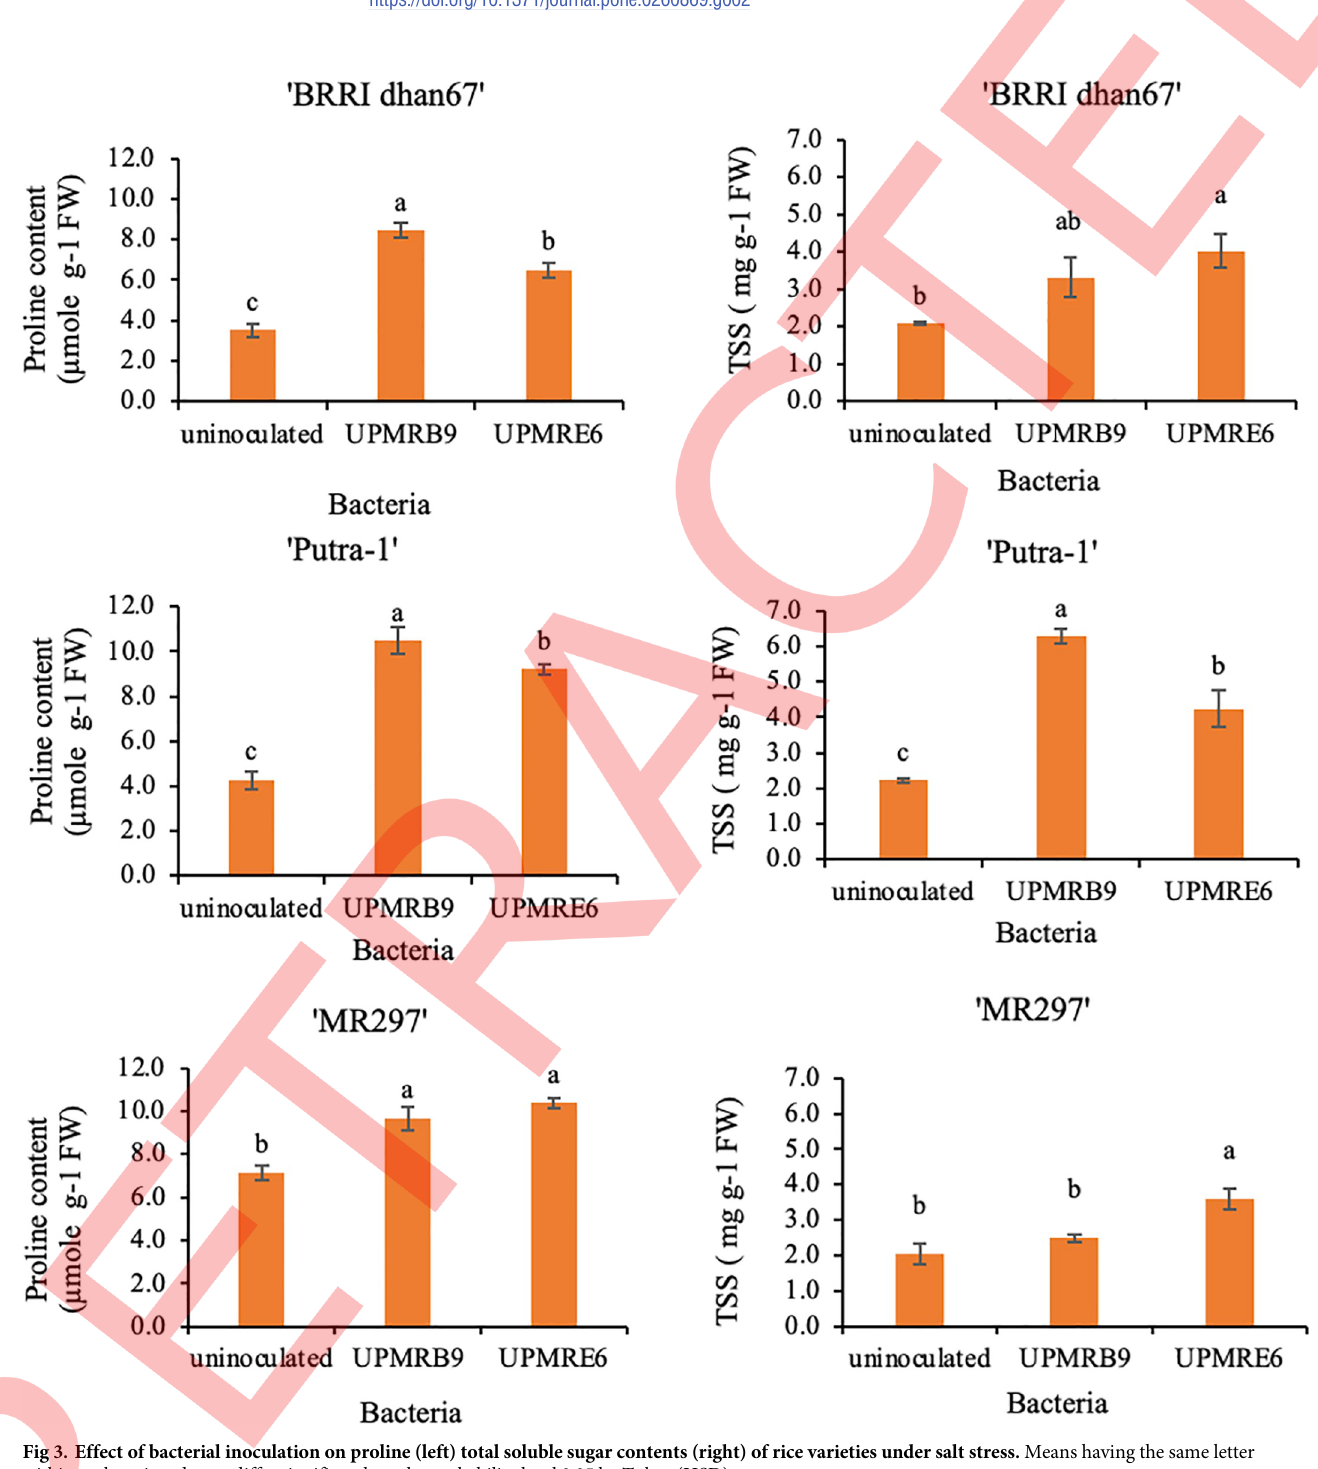
Fig 2. Effect of bacteria inoculation on malondialdehyde content of rice varieties under salt stress. Means having the same letter within each variety do not differ significantly at the probability level 0.05 by Tukey (HSD).